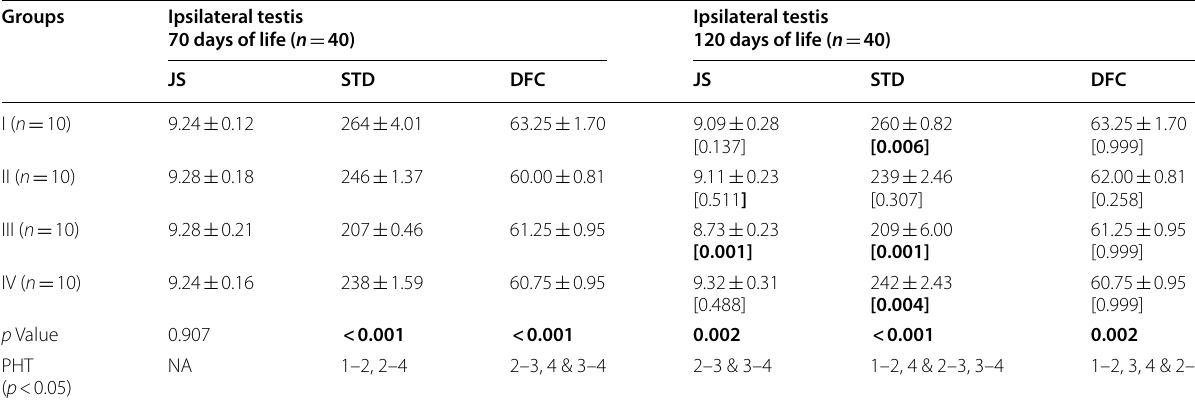
Data presented in mean standard deviation. One-way ANOVA test used between four (I, II, III, IV) groups followed by Post hoc test.; Independent samples t test used ± between ipsilateral hemi testis measured at 70 day and 120 days of life. PHT *JS Johnsen Score, STD seminiferous Tubular diameter, DFC = =